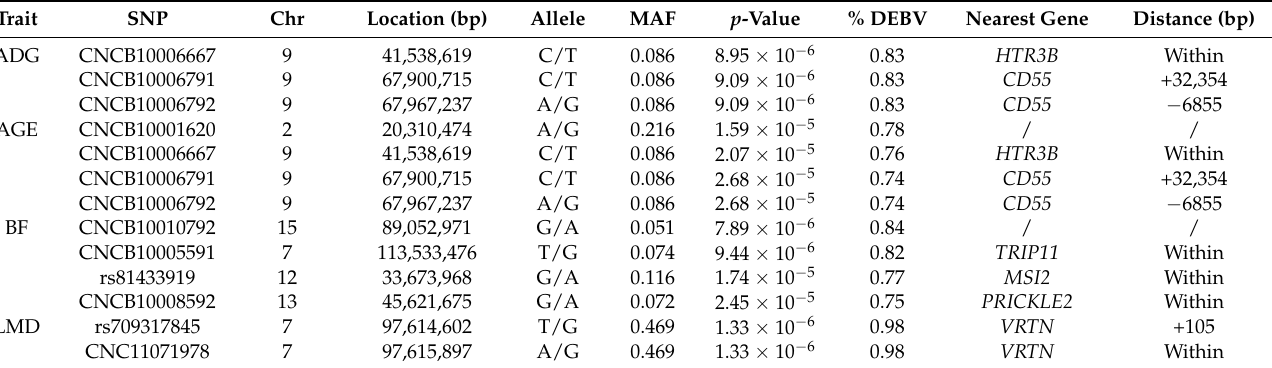
Table 2. Summary information of significant additive SNPs for ADG, AGE, BF, and LMD. Trait